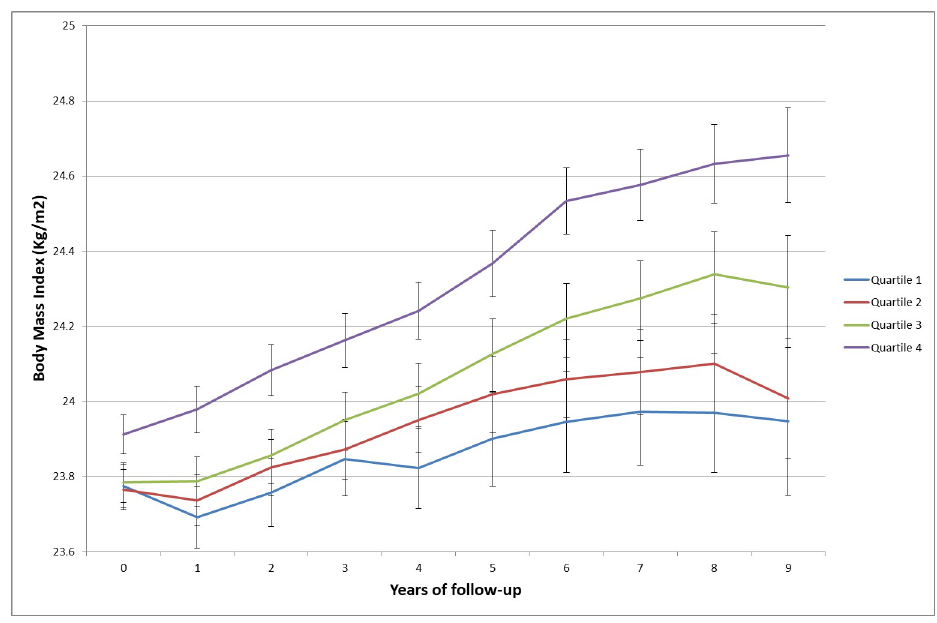
Fig 2. BMI change over time in the four quartiles of the proportion of UPF in the diet, NutriNet-Sante´, 2009–2019 ( n = 110,260). The average BMI for each year and each quartile of UPF intake is presented along with the 95% CI of the mean. BMI, body mass index; UPF, ultra-processed